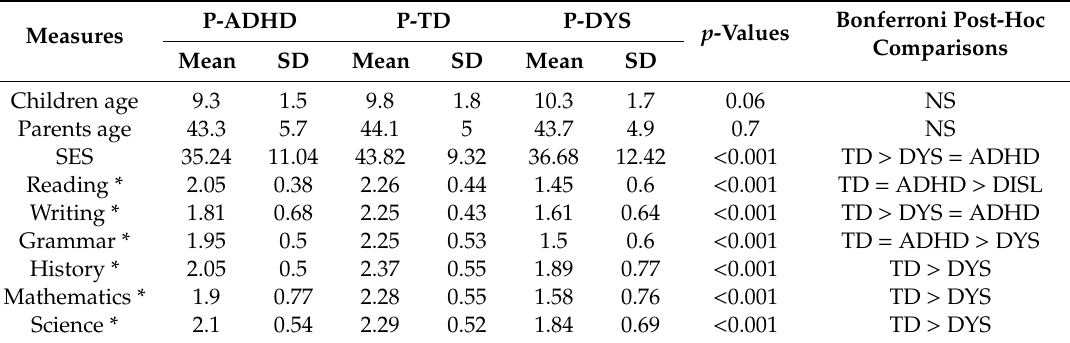
Bonferroni Post-Hoc p -Values Comparisons